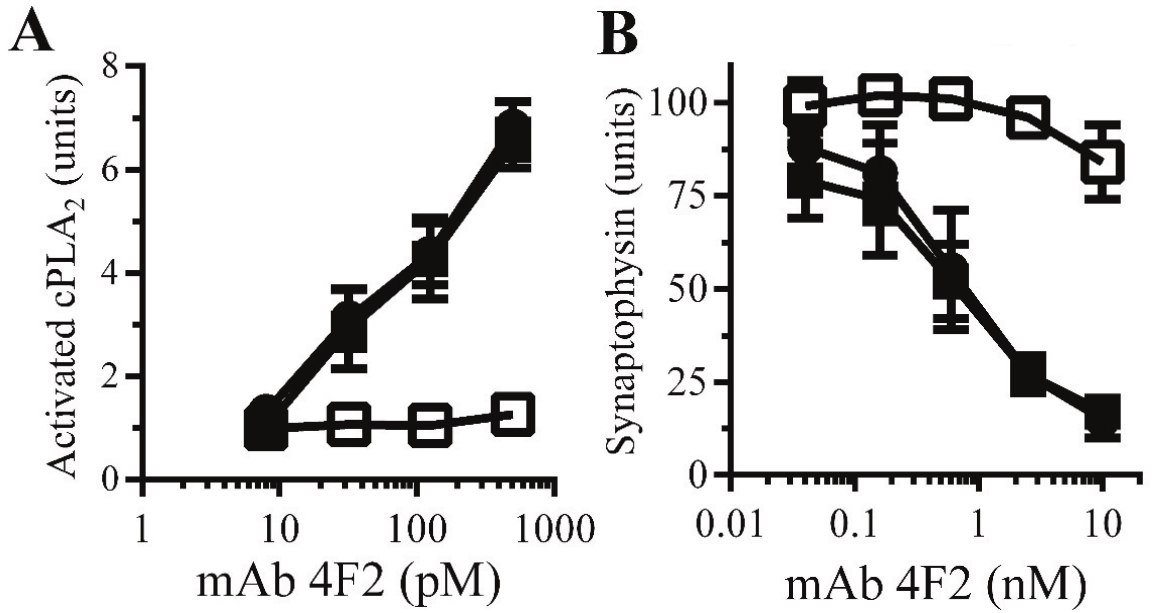
Figure 7. Monoacylated PrP C reduced mAb 4F2-induced synapse damage: ( A ) The amounts of activated cPLA 2 in synaptosomes pre- treated with control medium (●), 10 nM monoacylated PrP C (□) or 10 nM monoacylated Thy - 1 (■) and incubated with mAb 4F2. Values are means ± SD from triplicate experiments performed three times ( n = 9). ( B ) The amounts of synaptophysin in neurons pre- treated with control medium (●), 10 nM monoacylated PrP C (□) or 10 nM monoacylated Thy - 1 (■), incubated with mAb 4F2. Values are means ± SD from triplicate experiments performed three times, n =